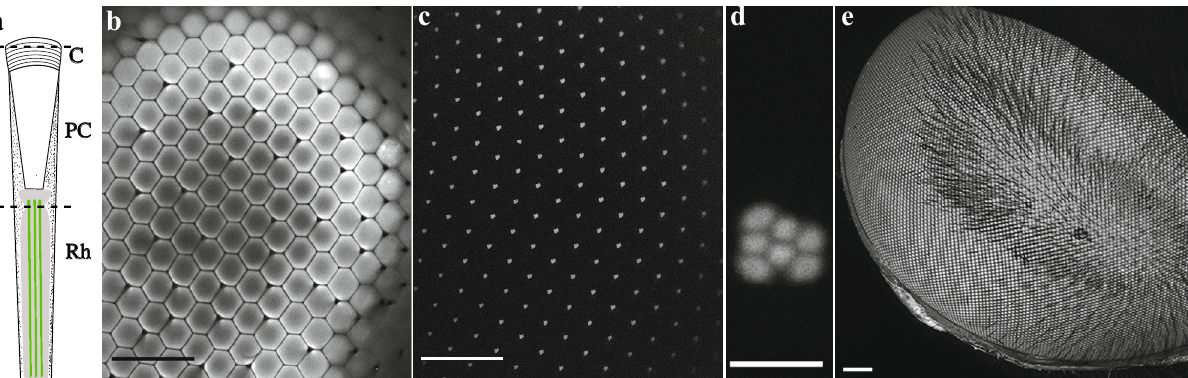
Figure 2. The fluorescence of the induced fluorescent pseudopupil originates from the rhabdomeres. (a) Diagram of a single ommatidium of a dipteran compound eye. Dotted lines denote the plane where optical cross sections of the eye in (b–d) were taken. From top to bottom: corneal facet (C), pseudocone (PC) and distal tip of the rhabdomeres (Rh). (b.c) Eristalis tenax compound eye after application of Lucifer Yellow and scanned with a confocal microscope, with a 63× glycerol objective. Scale bar 100 µm. The fluorescence observed at the surface of the eye (b) originates from the fluorescent rhabdomere tips as no other cells or parts of the photoreceptors are fluorescent when we focus below the cornea to the plane of the rhabdom tips (c) . (d) Magnified view from a single ommatidium, showing the distinctive trapezoidal shape formed by the distal tips of 7 adjacent rhabdomeres, typical of dipteran flies. Scale bar 5 µm. (e) Maximum intensity projection of a z-stack of the left eye of a female Eristalis tenax . When the dye (in this case Neurobiotin 488) had been